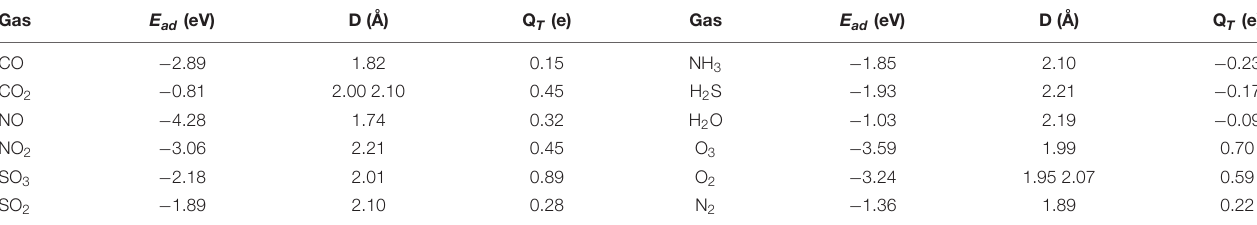
TABLE 1 | Adsorption energies ( E ad ), distances between Pt and the coordinated atoms (D), and the charge transferred between PtN 3 -CNT and the gas molecules for Gas@PtN 3 -CNT systems (Q T ).